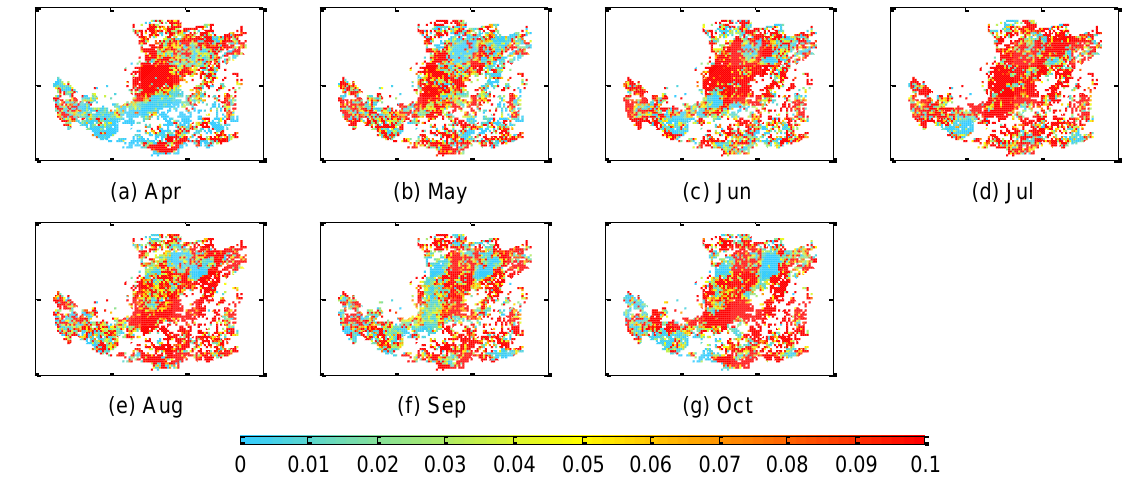
Figure 14. The significance level of a linear regression between NDVI and temperature in different months.